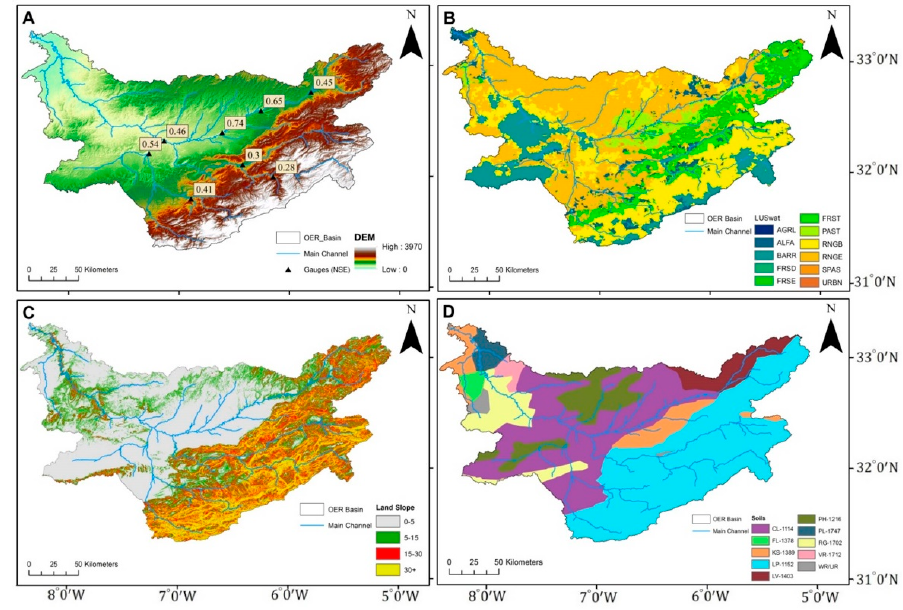
Figure 6. OER Model input: ( A ) Digital Elevation Model; ( B ) landuse; ( C ) percent slope; and ( D ) soils.